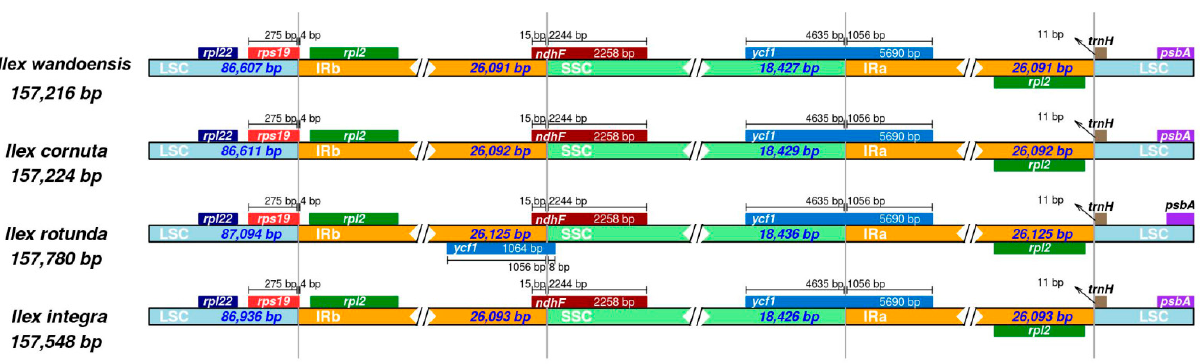
Figure 2. Distances between adjacent genes and junctions of the large single-copy (LSC), small single-copy (SSC), and two inverted-repeat (IR) regions among the chloroplast genomes of the four Ilex species.